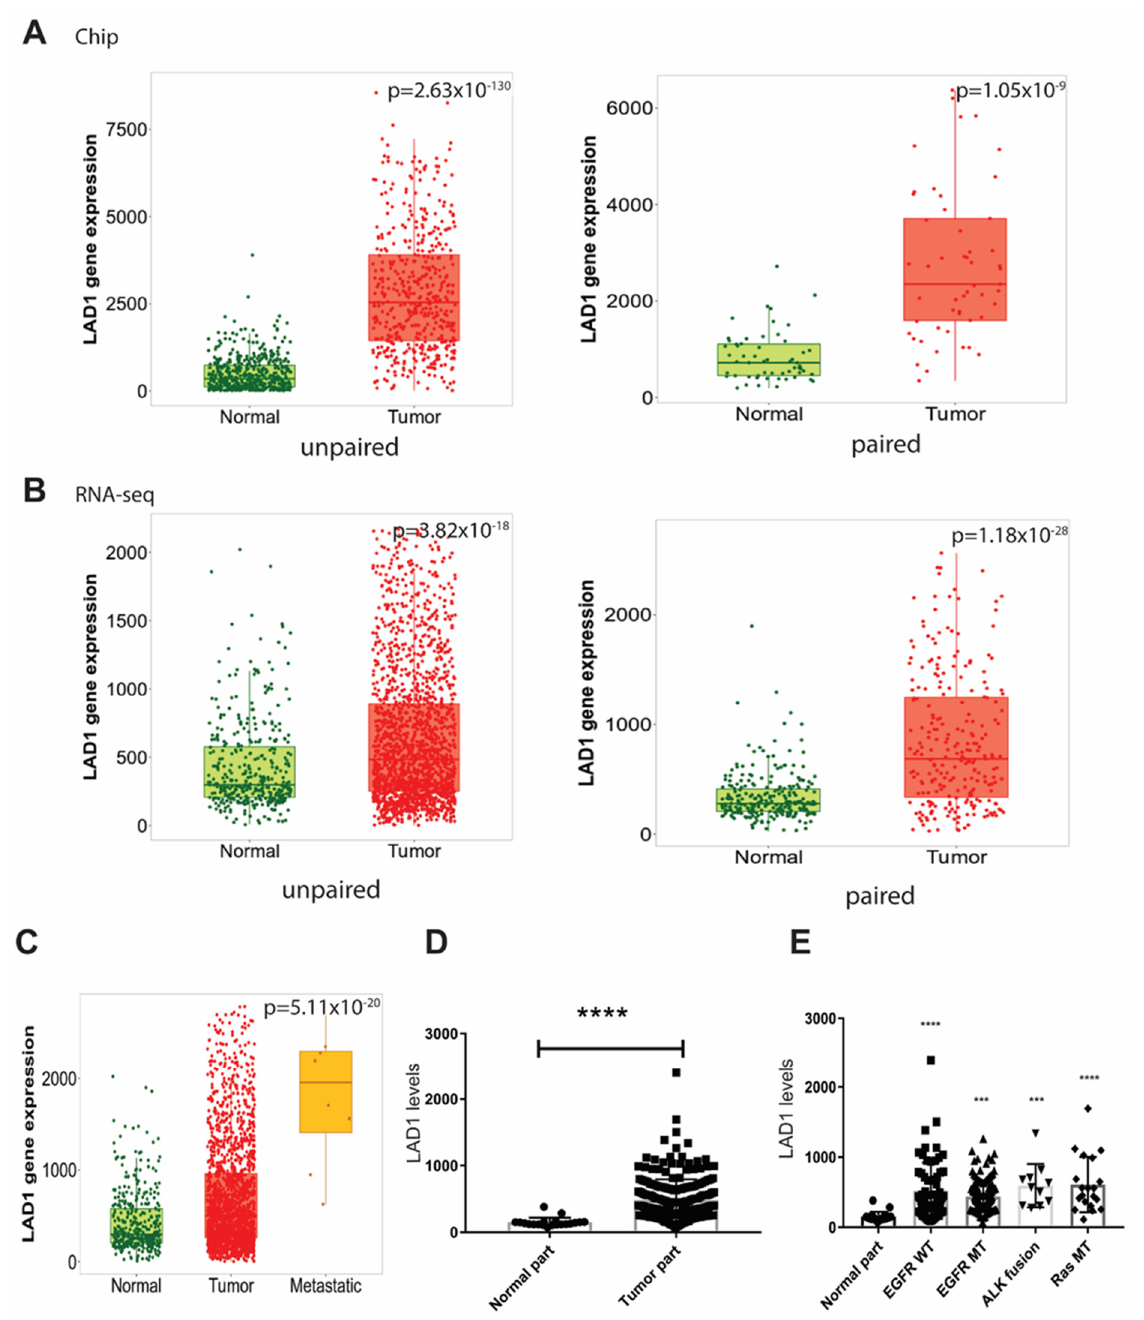
Figure 1. The mRNA expression of LAD1 in lung adenocarcinoma (LUAD) and its association with targetable mutated gene. ( A ) LAD1 expression in un-paired normal tissue and tumor (left) or paired tissue (right) of LUAD using gene chip data or ( B ) RNA − seq data from TNMplot website. All express at significantly higher levels in tumor parts than in normal tissues. ( C ) Comparison of the expression of LAD1 in normal, tumor, and metastatic tissues from gene chip data. ( D ) LAD1 expression in tumor and normal parts of pathological stages I to II lung adenocarcinoma from GSE31210. ( E ) Expression levels of LAD1 were significantly higher in tumors without epithelial growth factor receptor mutation (EGFR WT) and with EGFR mutation (EGFR MT), ALK fusion (ALK fusion), and KRAS mutation (RAS MT) than in normal parts from GSE31210. Green, normal parts; red, tumor parts; yellow, metastatic parts. (***, p < 0.005; ****, p < 0.001).